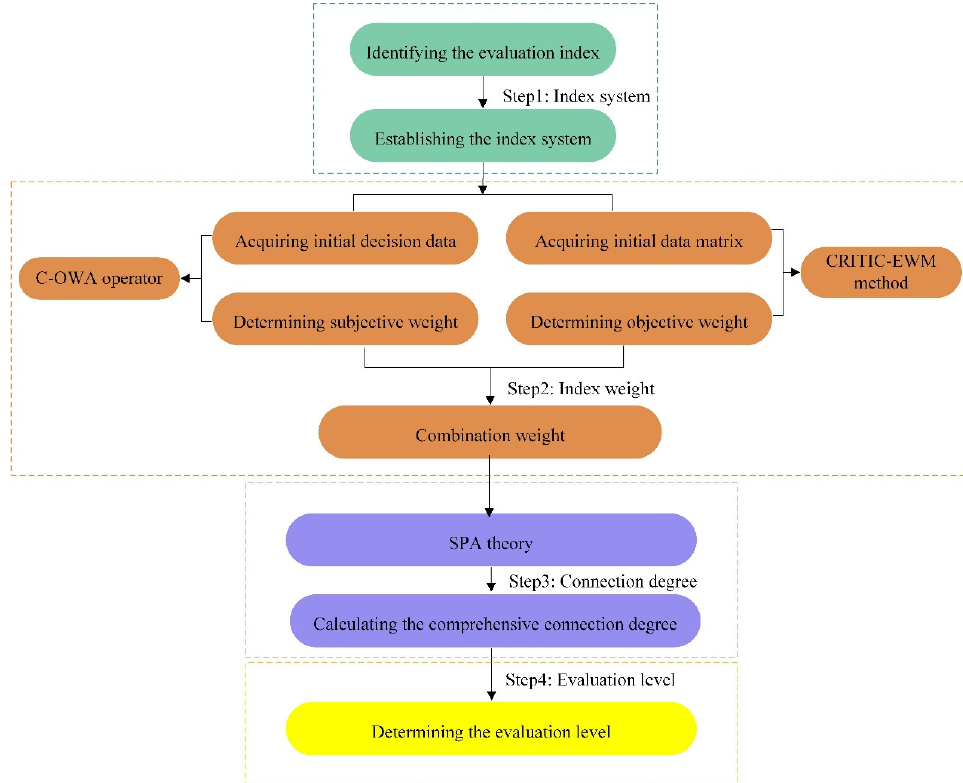
Figure 2. Flowchart of the proposed methodology.